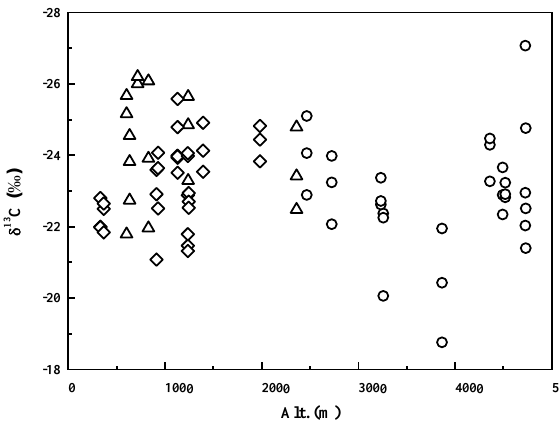
Figure 3. Shows the variance in surface soil δ 13 C with altitude.